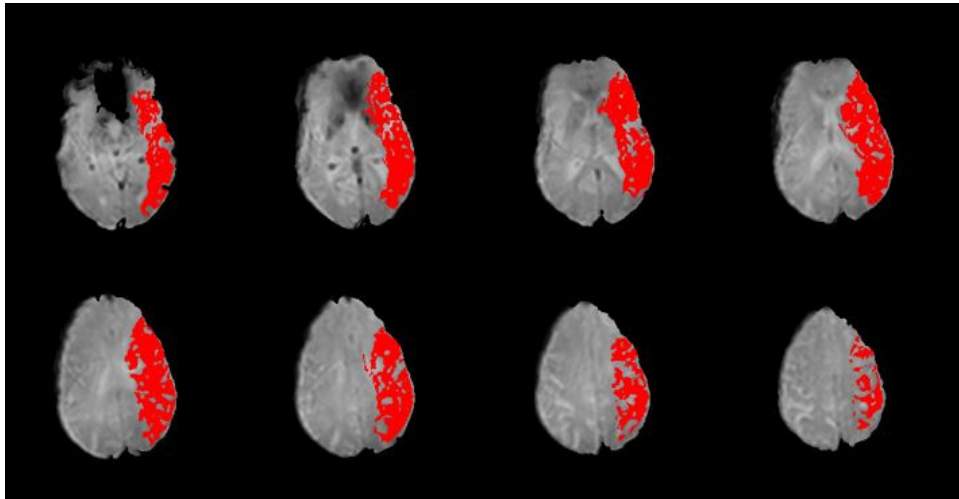
Figure 2. Sample slices from a participant’s PWI scan with time-to-peak (TTP) map overlay. A TTP delay of ≥ 4 s is shown in red. Per the slices included here, this participant would be coded as having a perfusion deficit present in all four regions of the MCA territory (frontal (MCA-F), temporal (MCA-T), parietal (MCA-P), and insular (MCA-I)).